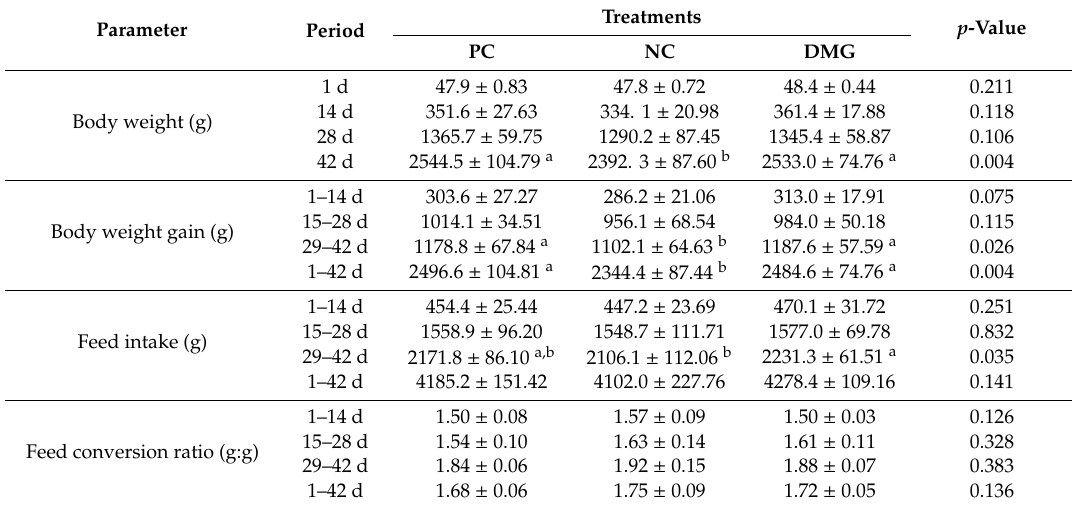
Table 2. Performance of broilers in each experimental group, measured at di ff erent growth stages.